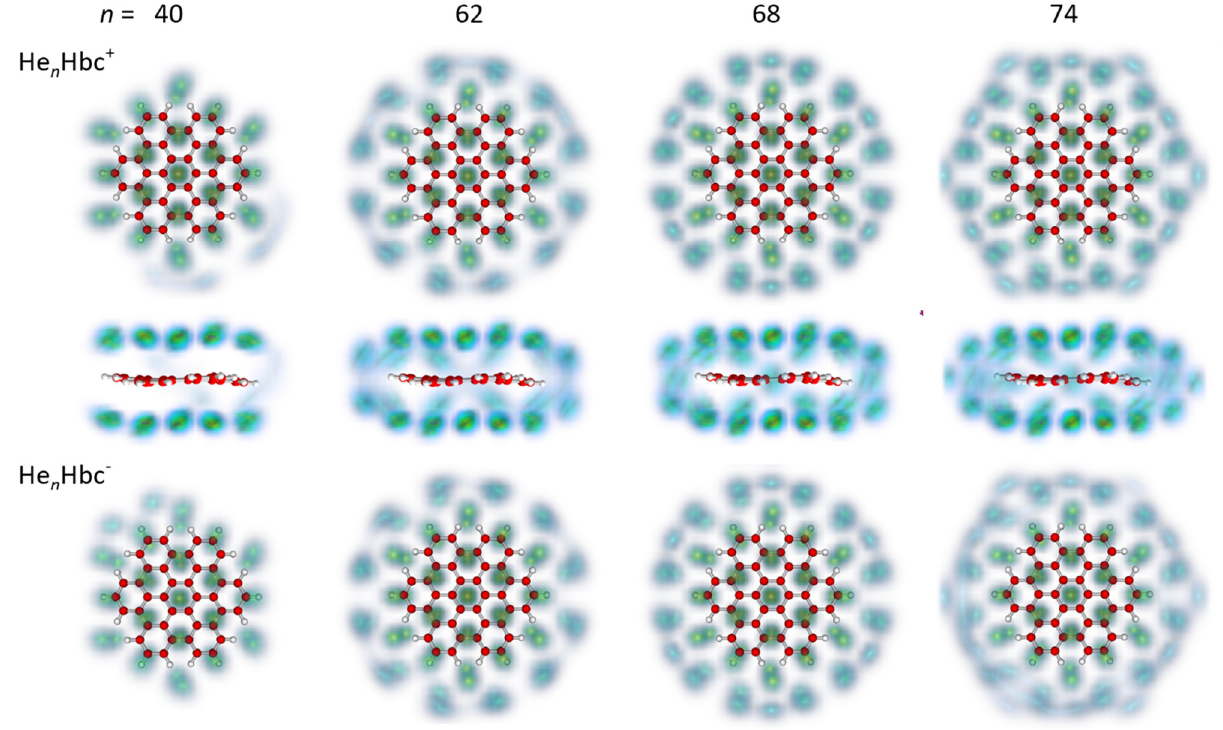
Figure 5. Selected structures of the He n Hbc + and He n Hbc – cluster ions (top and bottom row, respectively); the size n is indicated on top. For each size, the helium densities obtained from the PIMD simulations were superimposed on the structure of Hbc ± . Side views of the cationic clusters are shown beneath the corresponding front views.